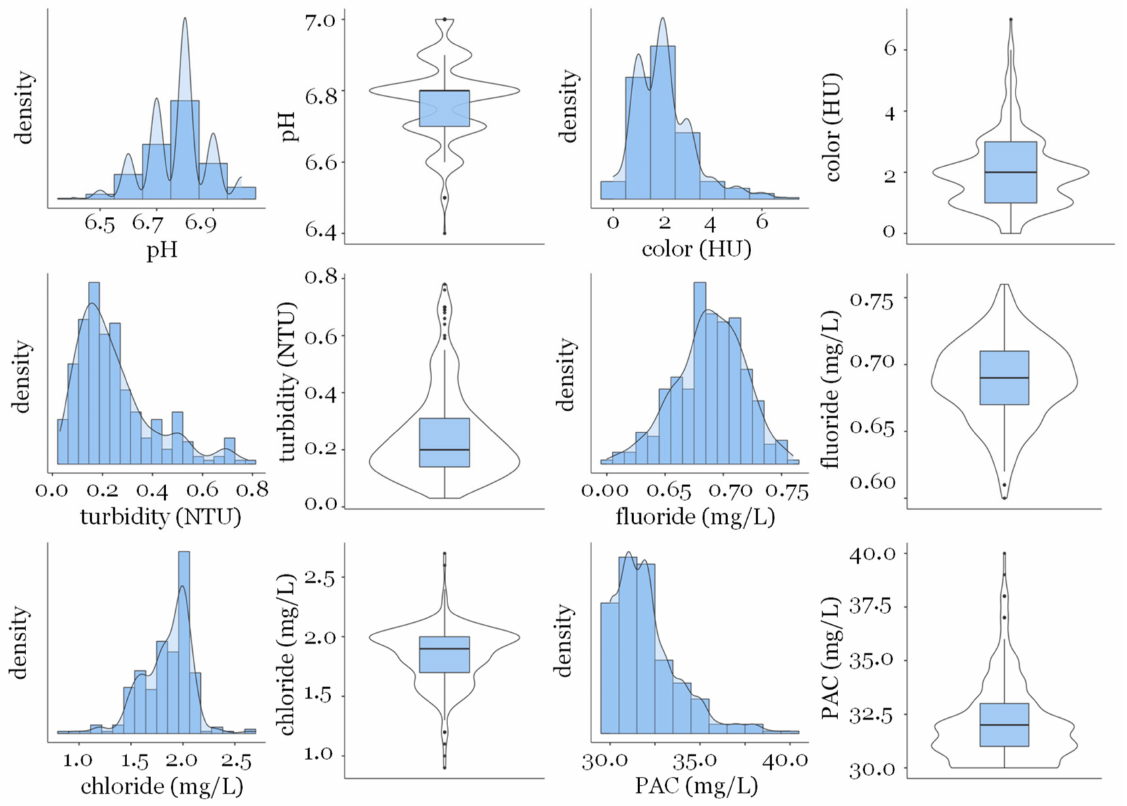
Figure 3. Exploratory analysis of quality indicator parameters of raw water and